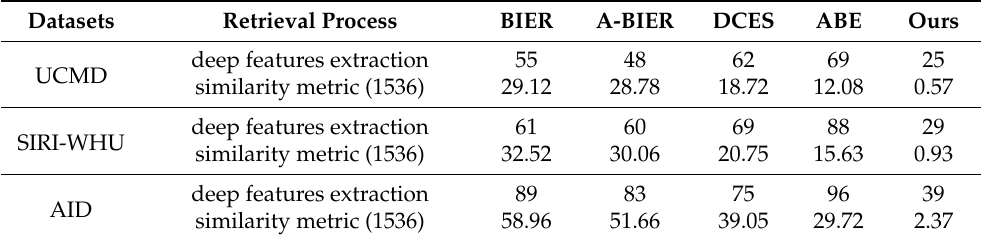
Table 8. Retrieval time (milliseconds) and time used for extracting image features (minutes) on AID with various RSIR